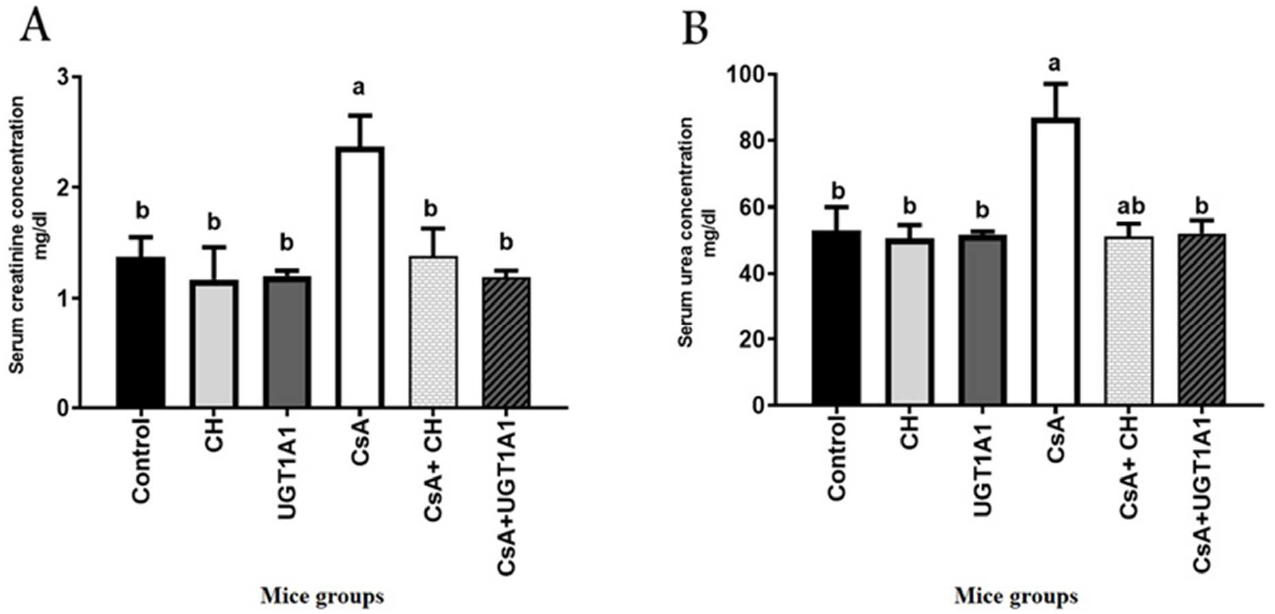
Figure 2. Physiological unconjugated hyperbilirubinemia protects against CsA-induced kidney dysfunction: ( A ) creatinine and ( B ) urea (U). Values are expressed as mean ± SEM ( n = 8). Means of different letters are statistically different ( p < 0.05) (ANOVA; Duncan’s post hoc analysis).